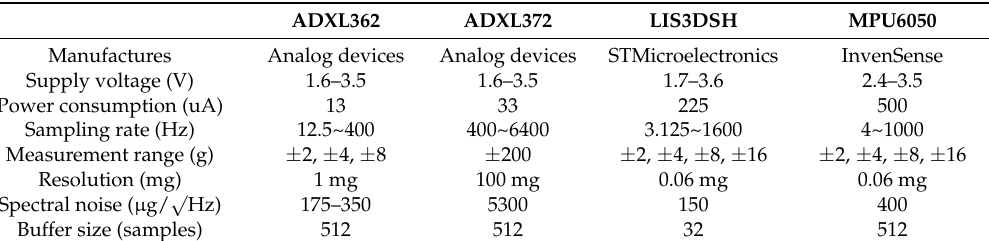
Table 1. Comparison of trigger accelerometers in the market [26–29].